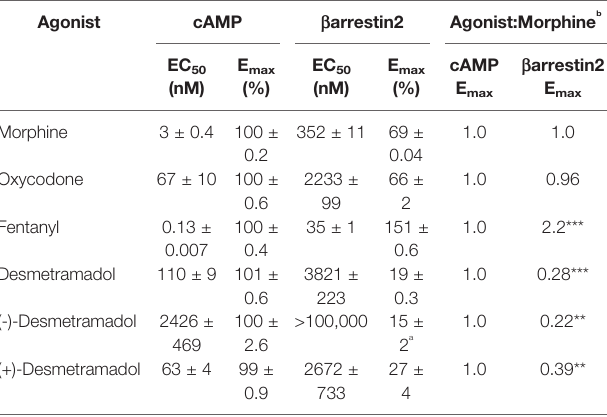
TABLE 1 | Human MOR-mediated G-protein modulated cAMP and b arrestin2 recruitment by control agonists (morphine, oxycodone, fentanyl), desmetramadol and its enantiomers.